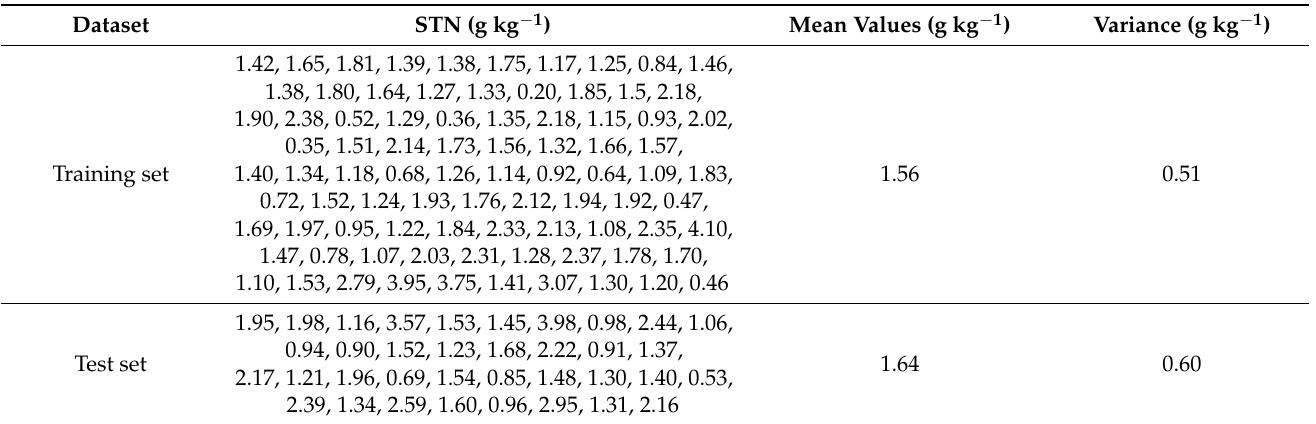
Table 2. Organic matter concentrations in soil